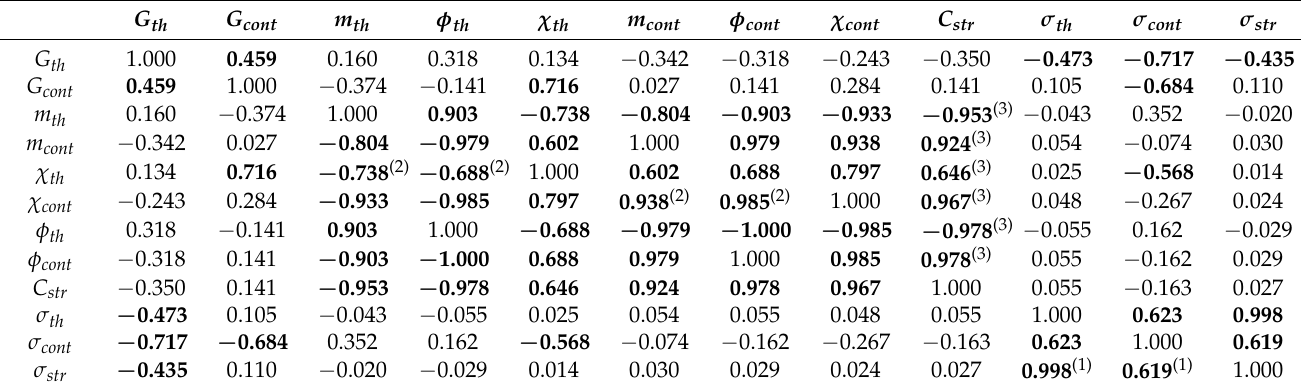
Table 7. Results of regression analysis 1